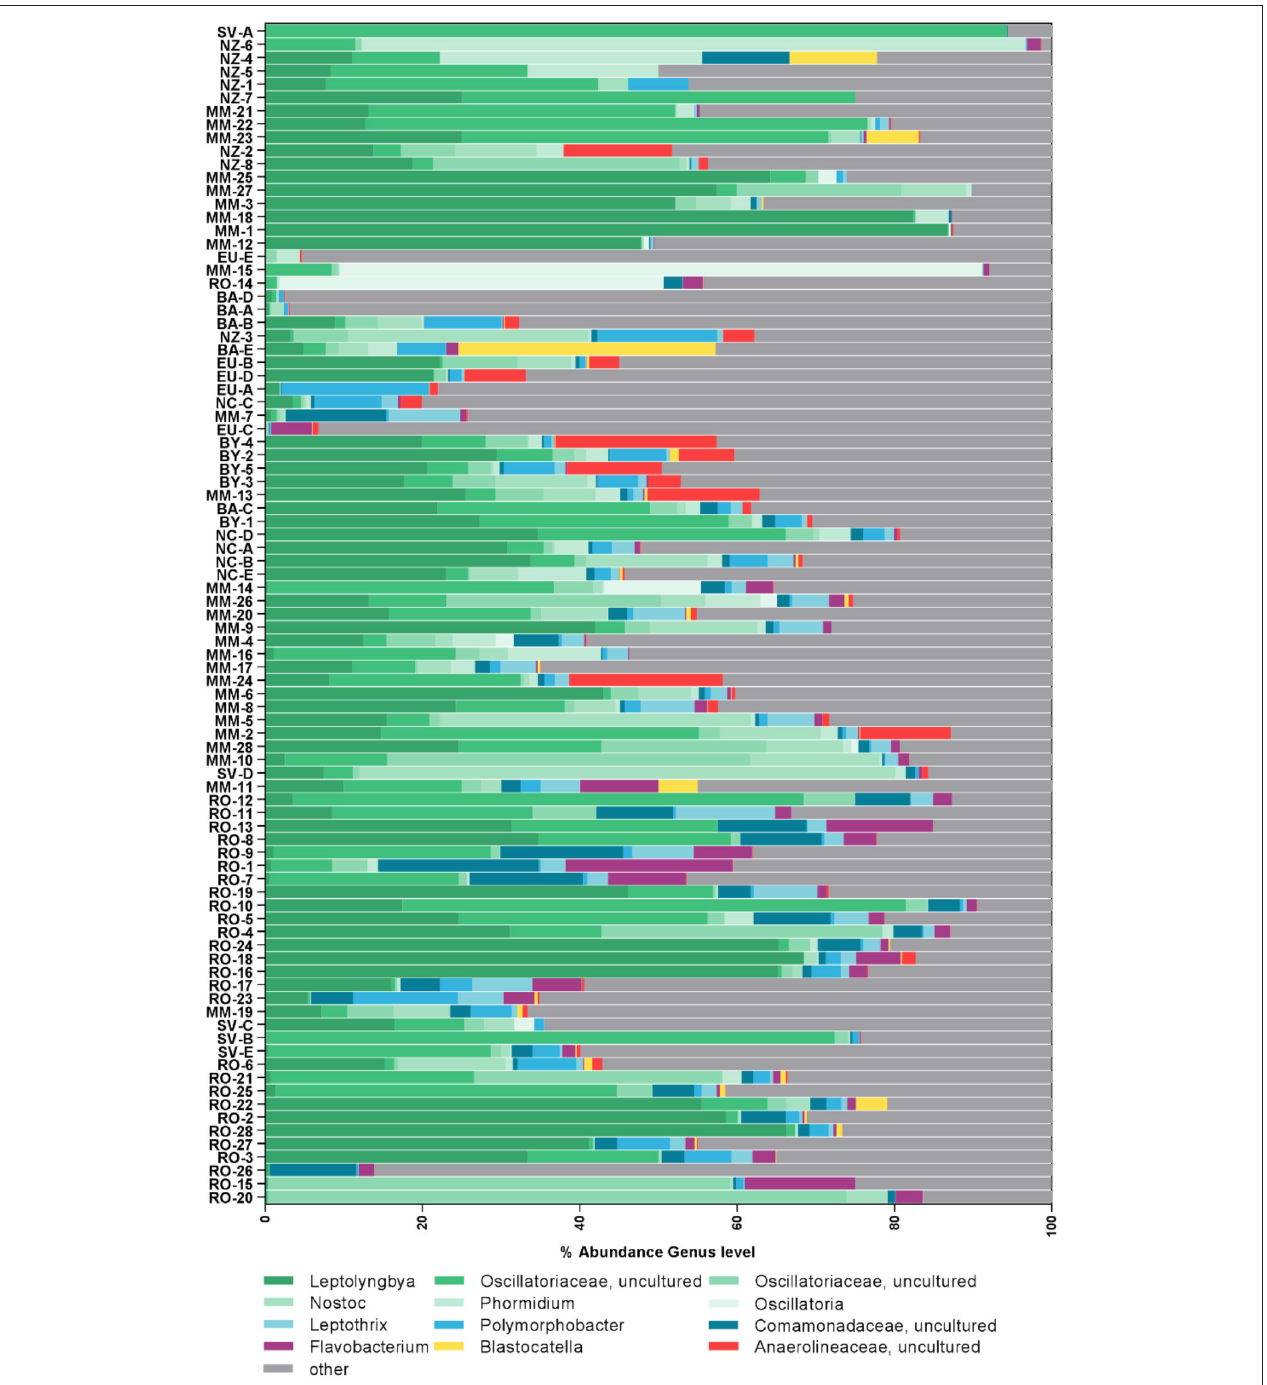
FIGURE 2 | Composition of most abundant bacterial genera in the samples. Samples are sorted according to similarity. Genera were assigned according to the SILVA database.